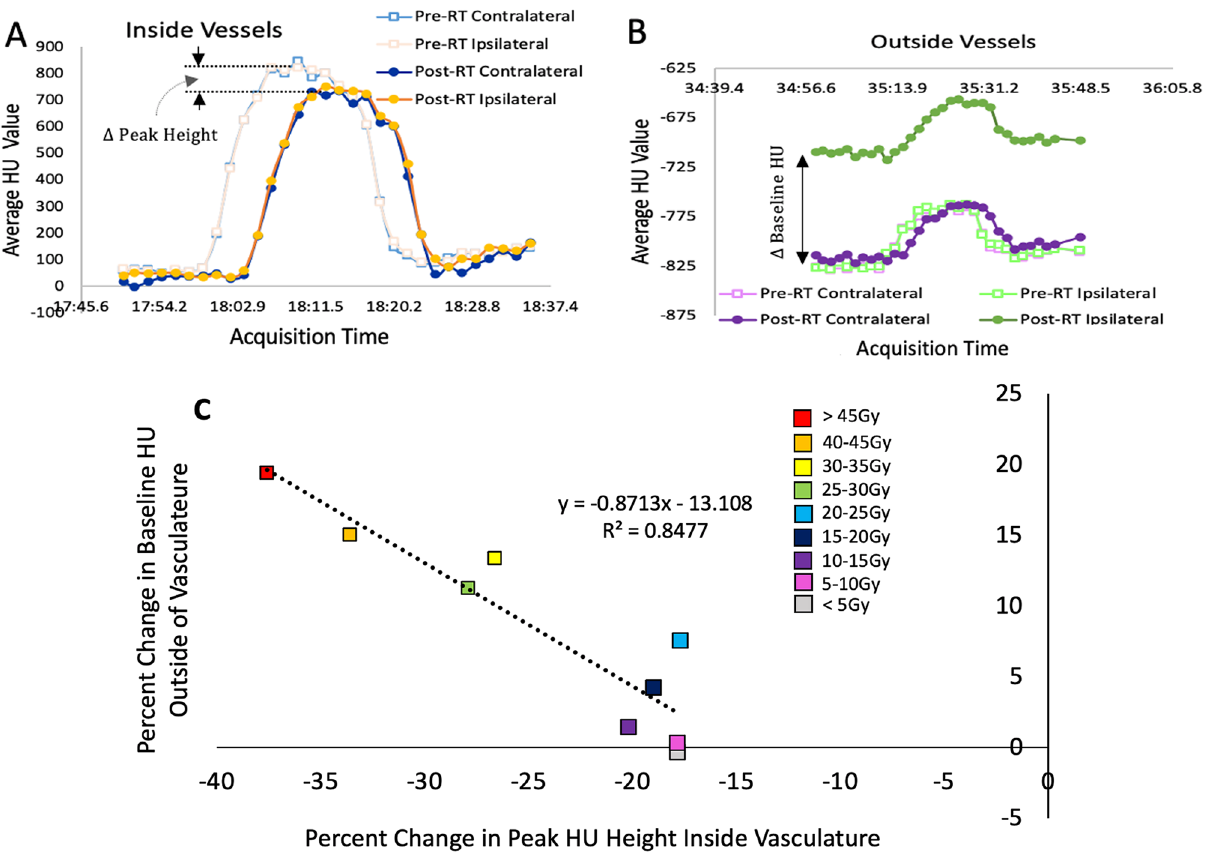
Figure 5. ( A ) Example contrast flow in the vessels pre- and post-RT for one WMS subject in the 20 Gy dose bin; by comparison the post-RT peak HU is reduced in magnitude. Here the acquisition times shown are the time of day for the pre-RT data. Since the specific times are insignificant, the post-RT data is plotted on the same timepoints. The important feature is the difference in the pre and post-RT peak HU values. ( B ) Example contrast flow outside of the vessels for the same WMS subject in the 20Gy dose bin; the post-RT ipsilateral region shows increased HU outside the vessels while the contralateral region does not increase. ( C ) Reduction in HU inside the vessels corresponds to an increase outside the vessels. Each point on the line corresponds to a different dose bin analyzed and is the average of all WMS subjects.